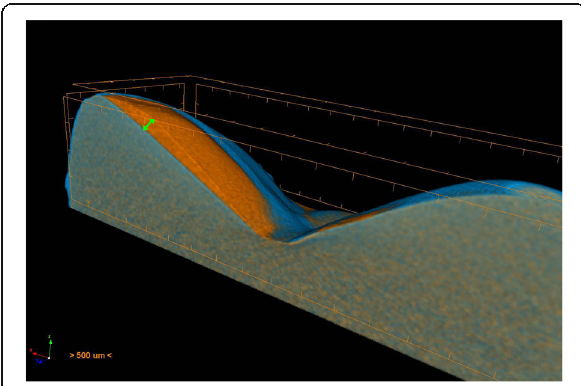
Fig. 3 Area of abrasion (yellow surface) and maximum vertical wear